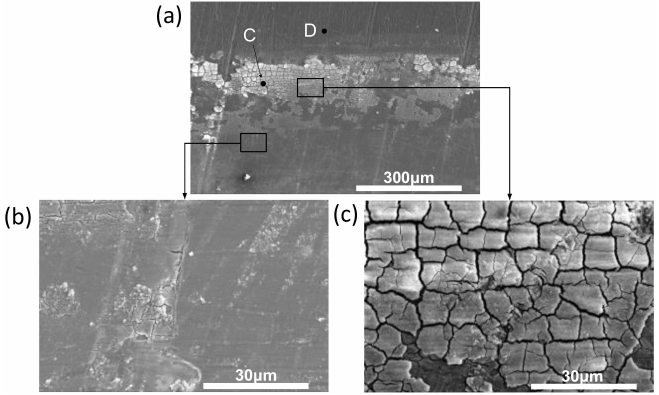
Figure 17. SEM micrographs of the TiCN coating worn surfaces in artificial seawater (P = 106 N): ( a ) Macro morphology; ( b ) Edge part; ( c ) Central part.